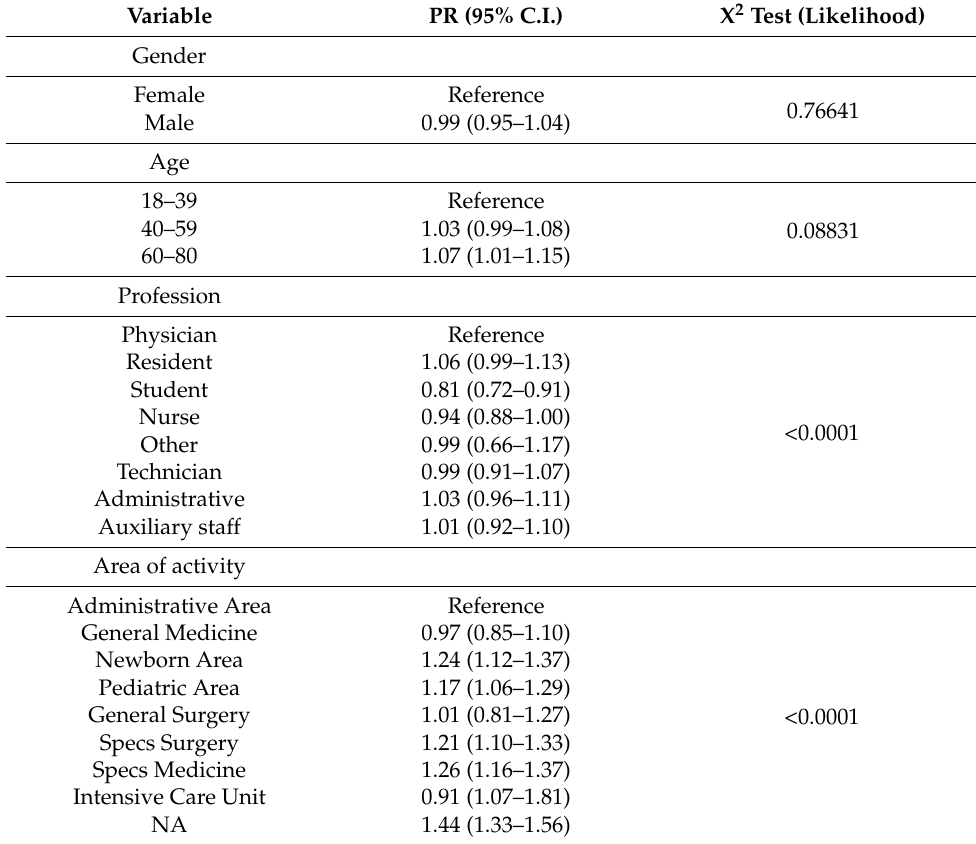
Table 2. Prevalence ratio of on-site vs ad hoc ambulatory.